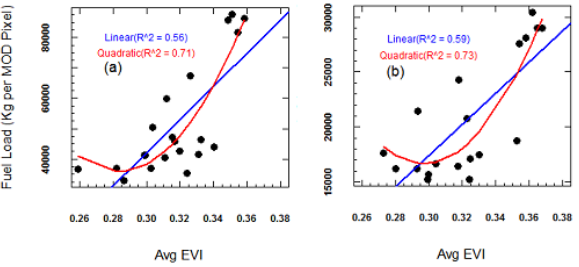
Figure 3. Scatter plot of fuel load and EVI of sample locations for (a) rice and (b) wheat per MODIS pixel.